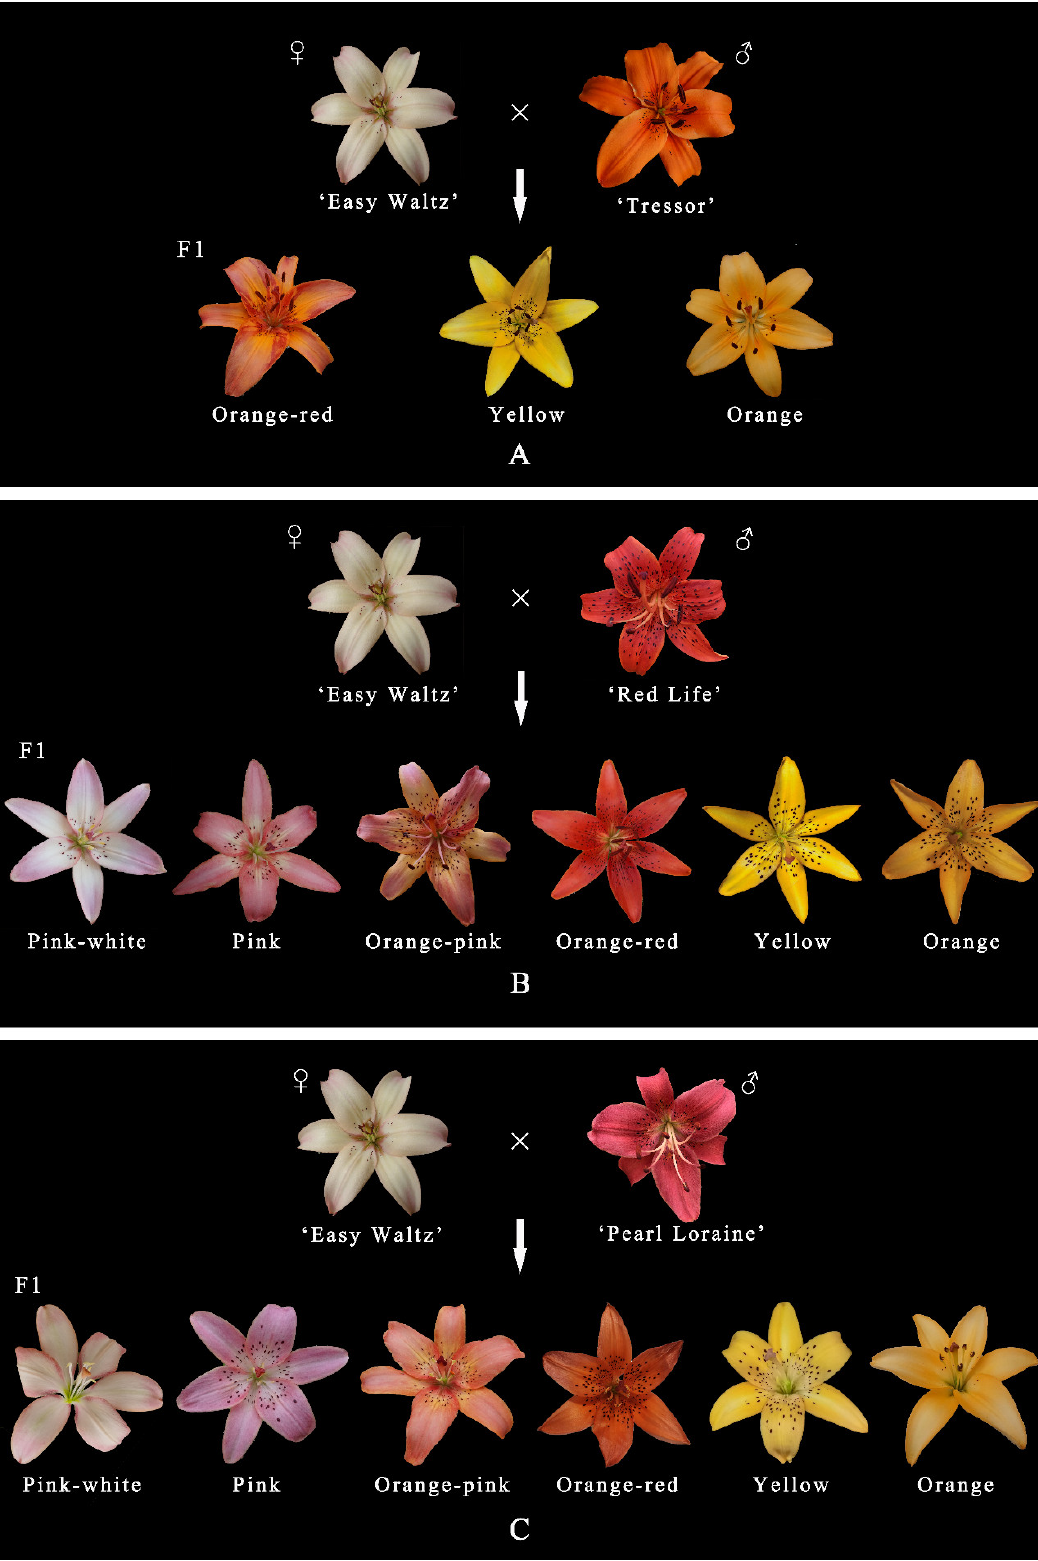
Figure 4. The typical pictures of different color groups in each combination. ( A – C ): F1 plants of EW01, EW02 and EW03; The F1 plants color groups are arranged from low to high according to the b* value.